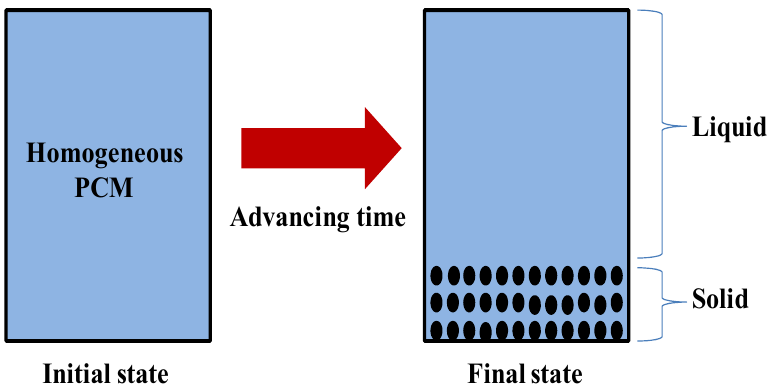
Figure 10. Phase segregation [3]., reprinted/adapted with permission from Ref. [3], 2022, Springer Nature.